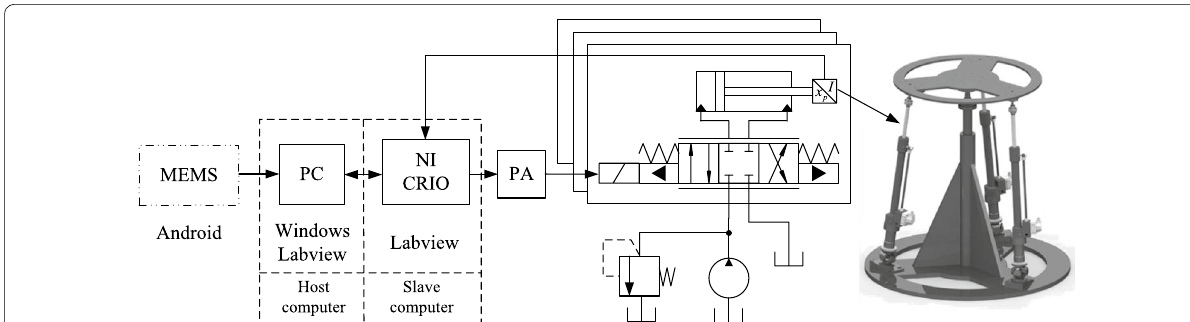
Figure 9 Control system of the hydraulic driven 3UPS/S manipulator